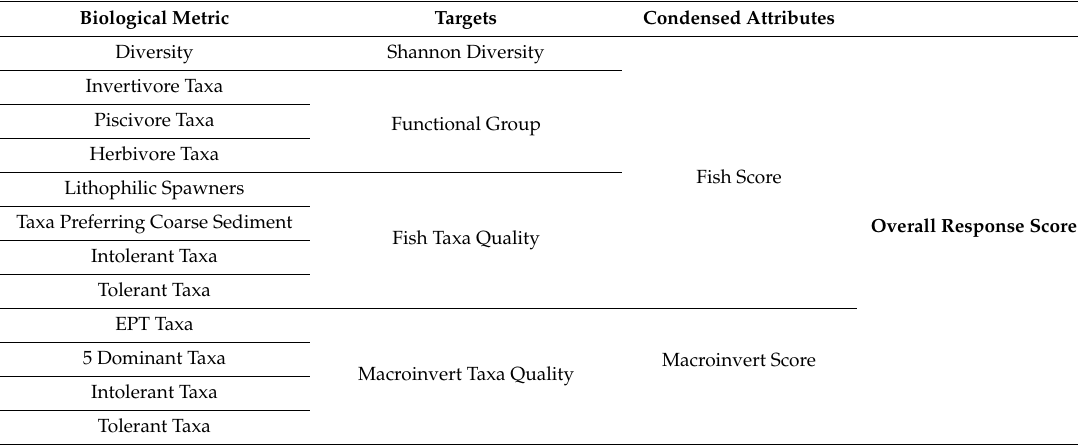
Table 2. List of final responses modeled with boosted regression trees and how each was condensed (i.e., averaged and grouped) into an average score to represent larger taxonomic